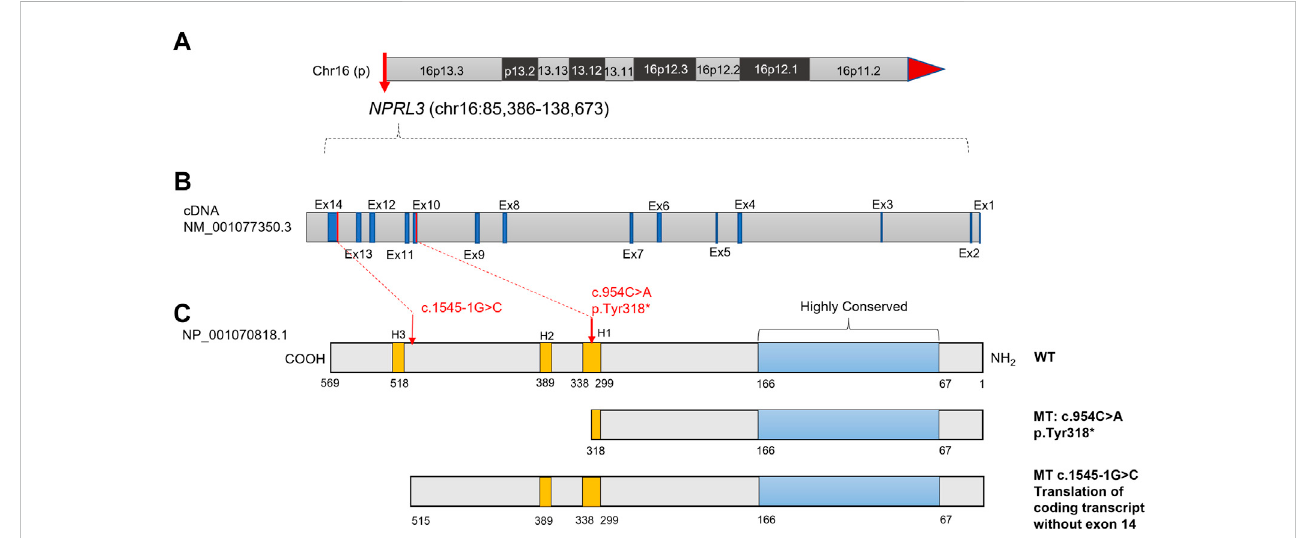
FIGURE 1 DiagramoftheNPRL3proteinwiththepositionsofthemutationsfoundinthetwofamilieswithFFEVF3. (A) Locationof NPRL3 geneonchromosome16. (B) Diagramofthe NPRL3 cDNA.Theexonswerehighlightedindarkblue,andtheredlinesindicatedthemutationposition. (C) DiagramoftheNPRL3protein. A highly conserved region at the N-terminus was highlighted in pale blue, the position of three Helix-turn-Helix domains H1, H2, and H3 was highlighted in yellow, and the red arrow indicates the mutation